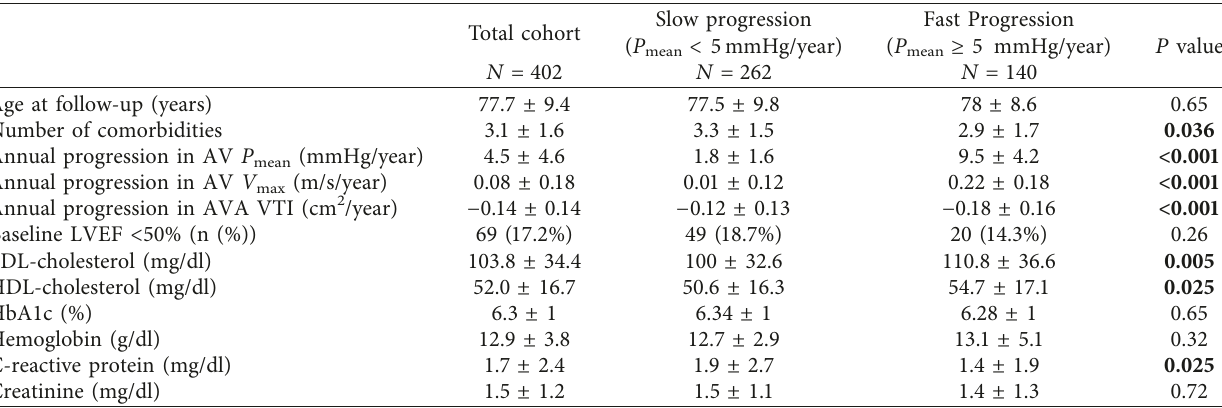
Table 3: Clinical and laboratory